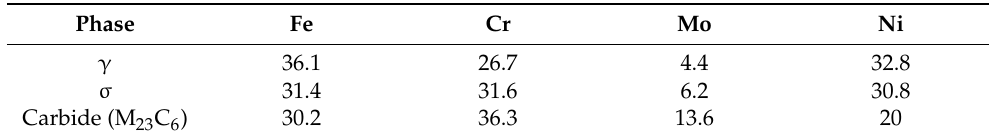
Table 2. The elemental composition from EDS analysis of the phases identified in the images in Figure